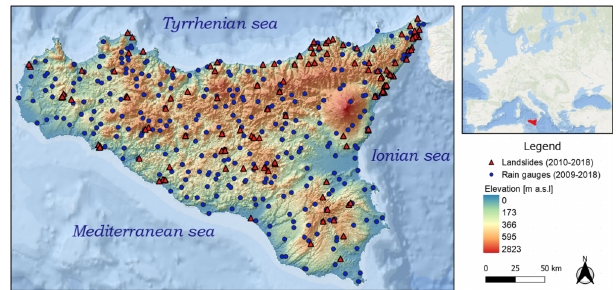
Figure 3. Elevation map of the study area (Sicily region), showing the location of the rain gauges and landslide occurrences (credit to http://www.sinanet.isprambiente.it/it/sia-ispra/download-mais, last access: 13 January 2023, and ESRI,